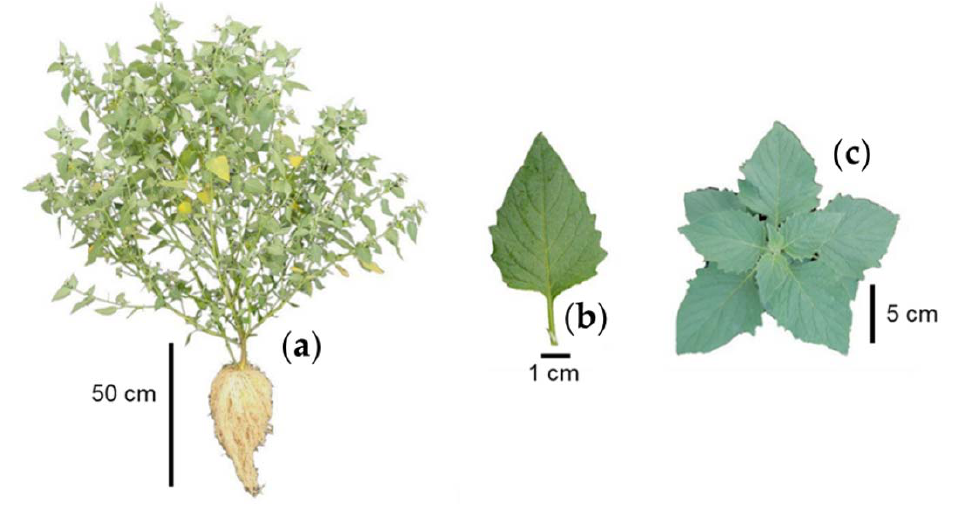
Figure 1. Whole plant ( a ), characteristics ( b ), and arrangement ( c ) of leaves of slender nightshade plant ( Solanum nigrescens ). Photos by Sara Monzerrat Ramírez-Olvera. Flowers are grouped in racemes composed of four flowers (Figure 2a). The corolla is base and yellow and purple colors in the center. The stamens are yellow with anthers 2.5